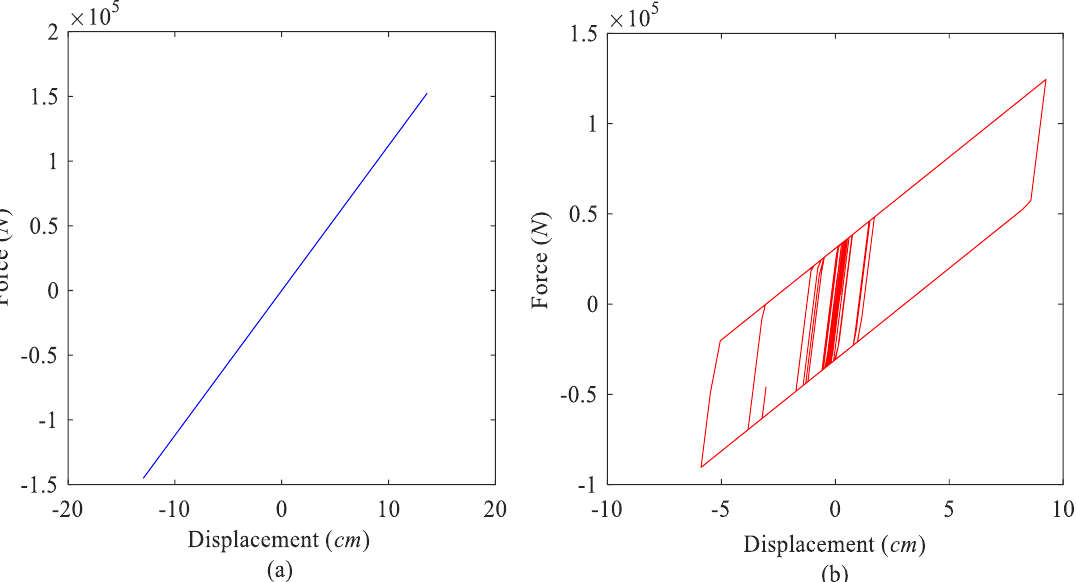
Fig. 15. (a) Force deformation behaviour of LRB (b) Force deformation behaviour of LPB under Chamoli